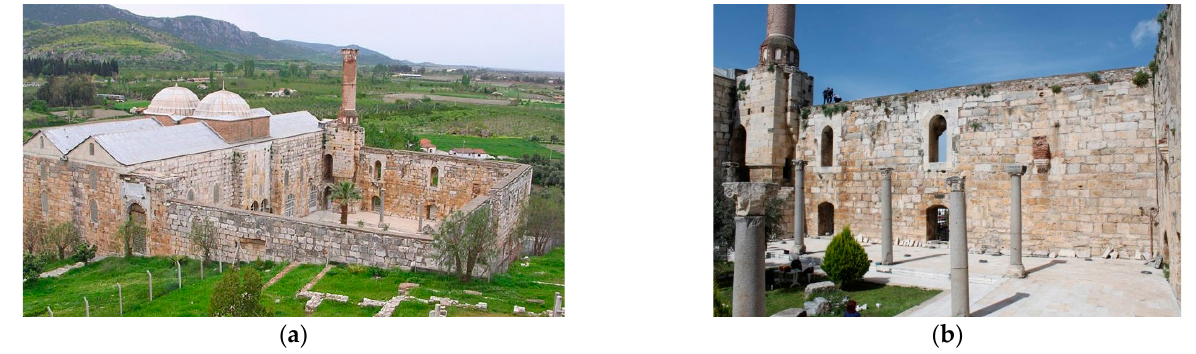
Figure 2. ( a ) A general view of Isabey Mosque and ( b ) the inside view of the West courtyard wall [38].